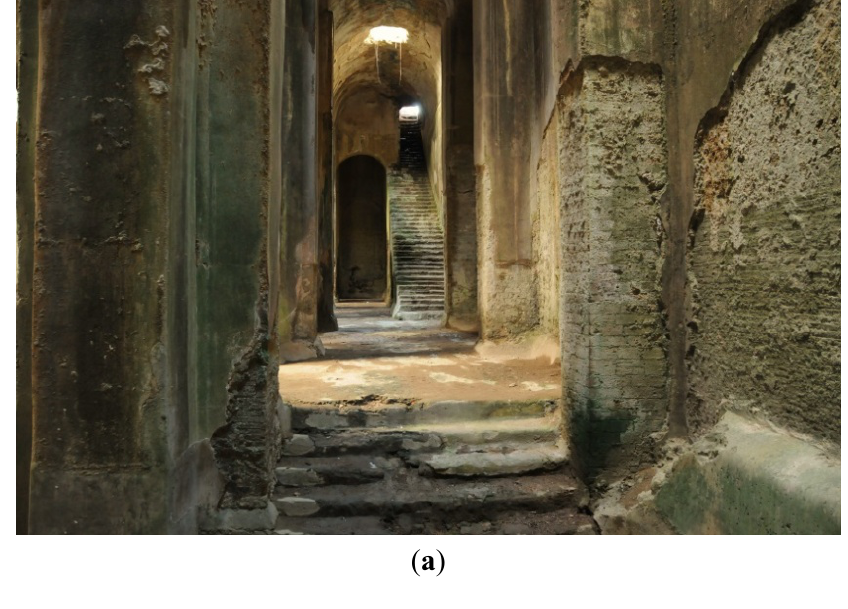
Figure 9. Piscina Mirabilis: ( a ) Photograph (copyright by L.W. Mays); ( b ) Plan view; and ( c ) Cross-section view